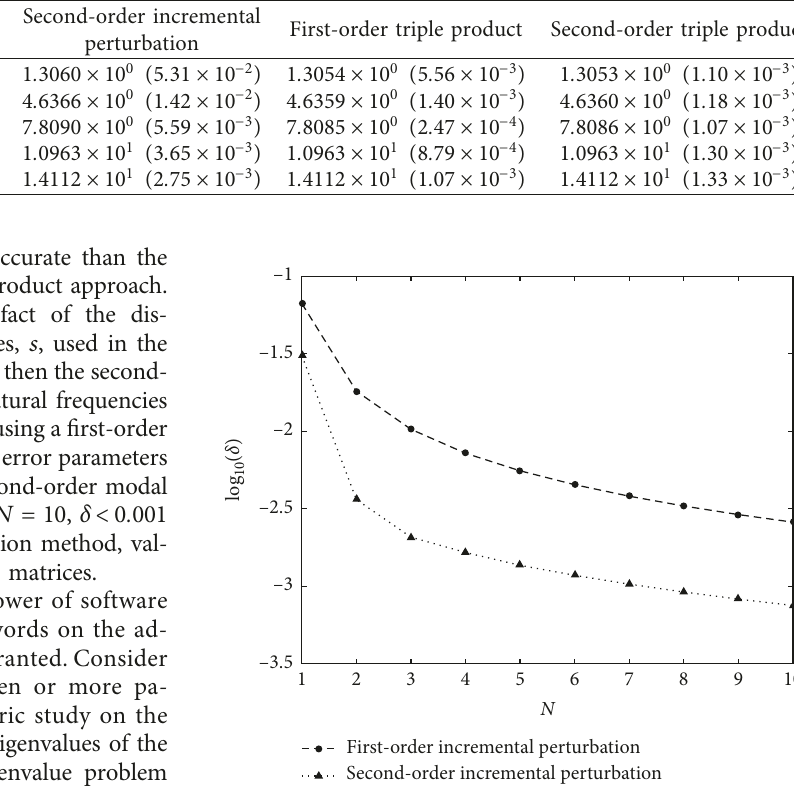
Table 12: The exact and approximate natural frequencies for the nonuniform rod at N � 10 for a � 0 . 55. The natural frequencies are ������� 􏽰 E / ( ρ L 2 ) nondimensionalized by dividing by